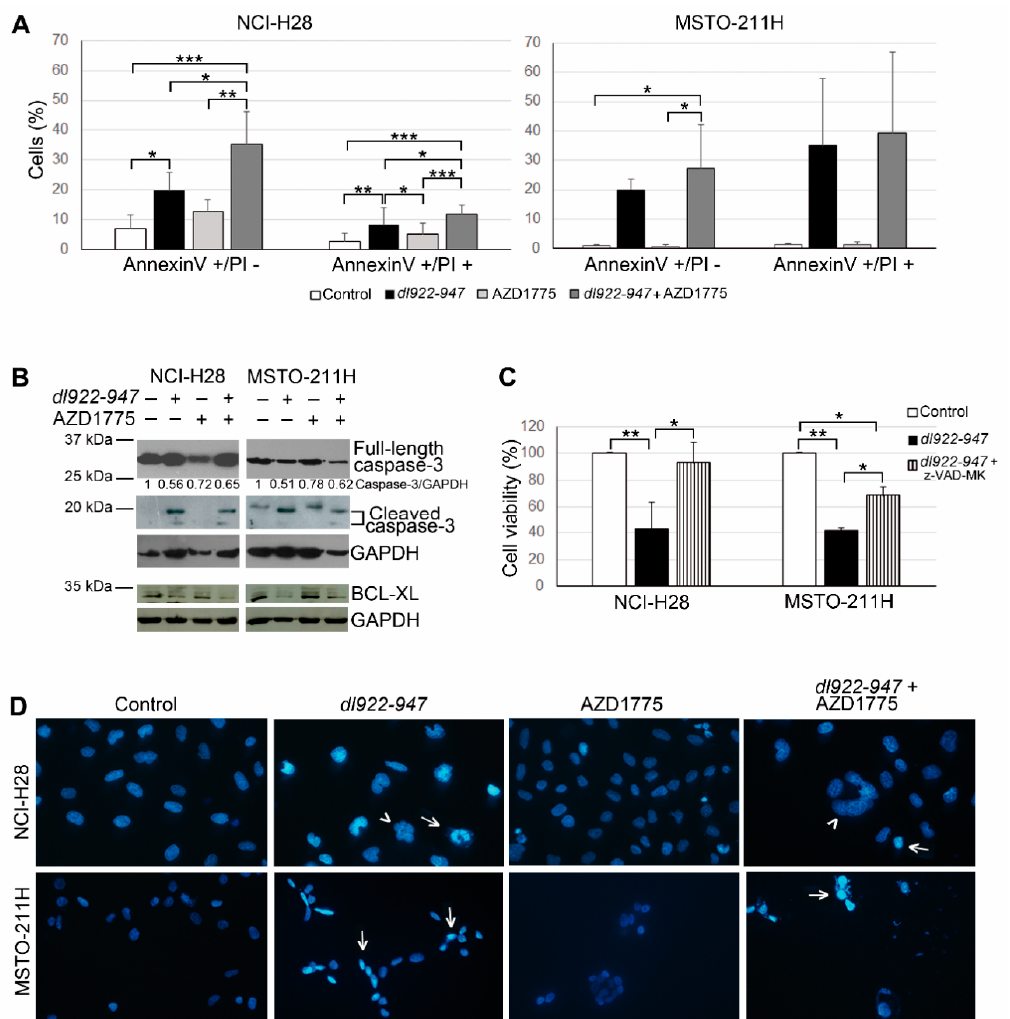
Figure 2. Cell death induction in malignant mesothelioma (MM) cells treated with dl922-947 and/or AZD1775. ( A ) Histograms report the means with standard deviations of at least three independent experiments representing the percentage of positive cells stained with annexinV–FITC and propidium iodide (PI) 96 h after treatment with dl922-947 and/or AZD1775 or DMSO, as a control. Statistically significant differences were evaluated by one-way repeated measures ANOVA with Tukey post-test and indicated as follows: * p < 0.05, significant; ** p < 0.01, very significant; and *** p < 0.001, extremely significant. ( B ) Caspase-3 and BCL-XL protein levels were analyzed by Western blotting in NCI-H28 and MSTO-211H cells treated as reported above. The antibody against caspase-3 detects both the full-length protein and the active cleaved form, which are shown separately at different exposure times (the full-length protein bands are shown at a shorter exposure time because they become overexposed at the time necessary for cleaved caspase-3 bands to appear). GAPDH was used as a loading control. Full-length caspase-3 band densities were quantified by densitometric analysis and normalized with the GAPDH band densities. Data are presented as relative values with respect to control values, set at 1. ( C ) Histograms reporting NCI-H28 and MSTO-211H cell viability 96 h after treatment with dl922-947 alone and in combination with Z-VAD-FMK. Results represent the means with standard deviations of at least 2 independent experiments, each conducted in triplicate, and are expressed as percentages of cell viability calculated with respect to untreated control cells. Statistically significant differences were evaluated by one-way repeated measures ANOVA with Tukey post-test and indicated as follows: * p < 0.05, significant; ** p < 0.01, very significant. ( D ) Representative fluorescence micrographs of DAPI-stained NCI-H28 and MSTO-211H cells treated with dl922-947 and/or AZD1775 as reported above. Arrows indicate some of the nuclei with clumped or condensed chromatin; arrowheads indicate some multilobed nuclei or